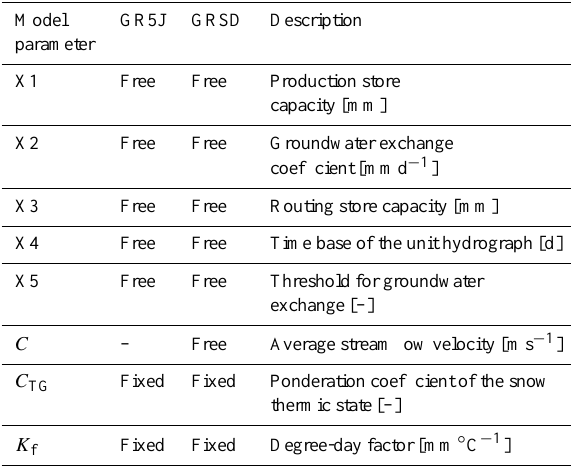
Table 1. List of the parameters for the semi-distributed conceptual rainfall–runoff model